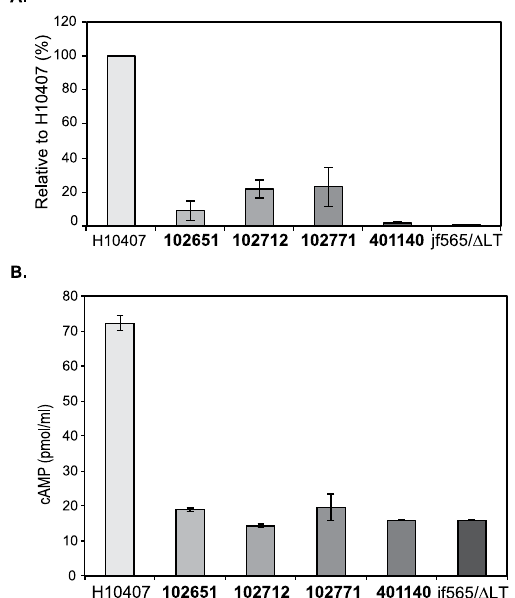
Figure 8. ETEC LT secretion and cAMP activation in target epithelial cells. ( A ) LT in culture supernatants from the EPEC/ETEC hybrids compared to the prototype ETEC isolate H10407, as measured by a GM1- ganglioside binding assay. The negative controls are isolate 401140 and jf565/ Δ LT, which lack the eltAB genes. ( B ) Functional effectiveness of heat-labile toxin was determined by examination of cAMP production in target Caco-2 epithelial cells following infection with mutant strains relative to the wild type H10407, or the jf565 eltAB mutant. The EPEC/ETEC isolates are indicated in